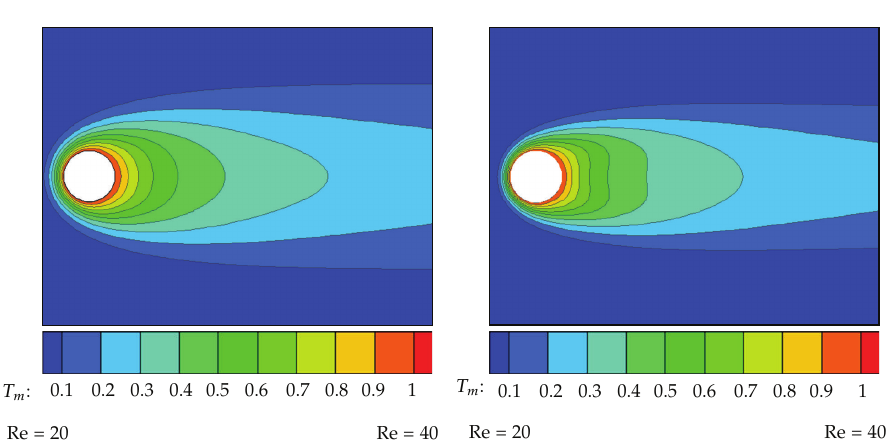
Figure 1: Temperature contours for steady forced convection from a stationary circular